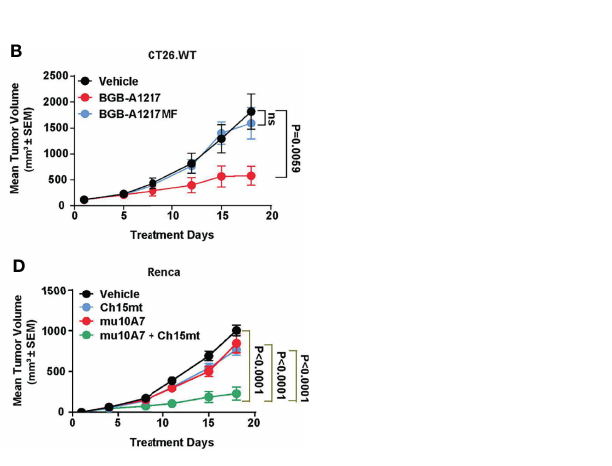
were treated with indicated antibodies (10 mg/kg, Q5D), N = 10. (C) MC38 tumor-bearing humanized TIGIT knock-in mice were treated with vehicle (DPBS), Ch15mt (1 mg/kg, Q5D), BGB-A1217 (3 mg/kg, Q5D) or the combination; N = 10. (D) Renca tumor-bearing mice were treated with murine TIGIT blockade antibody mu10A7 (5 mg/kg, QW), murine PD-1 blockade antibody Ch15mt (3 mg/kg, QW), or the combination as indicated. N = 15; Data shown as mean ± SEM. Comparison between each treatment and the vehicle group on the last day was performed using one-way ANOVA with Dunnett multiplicity adjustment (A, B) . Comparison between the combination treatment and each single agent treatment on the last day was performed using Tobit model (C, D) . ns, no signi fi cant